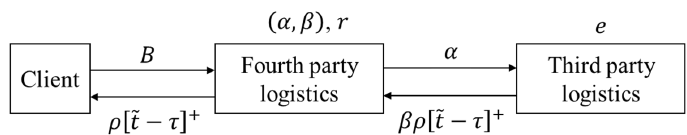
Fig. 1. The model of the logistics service supply